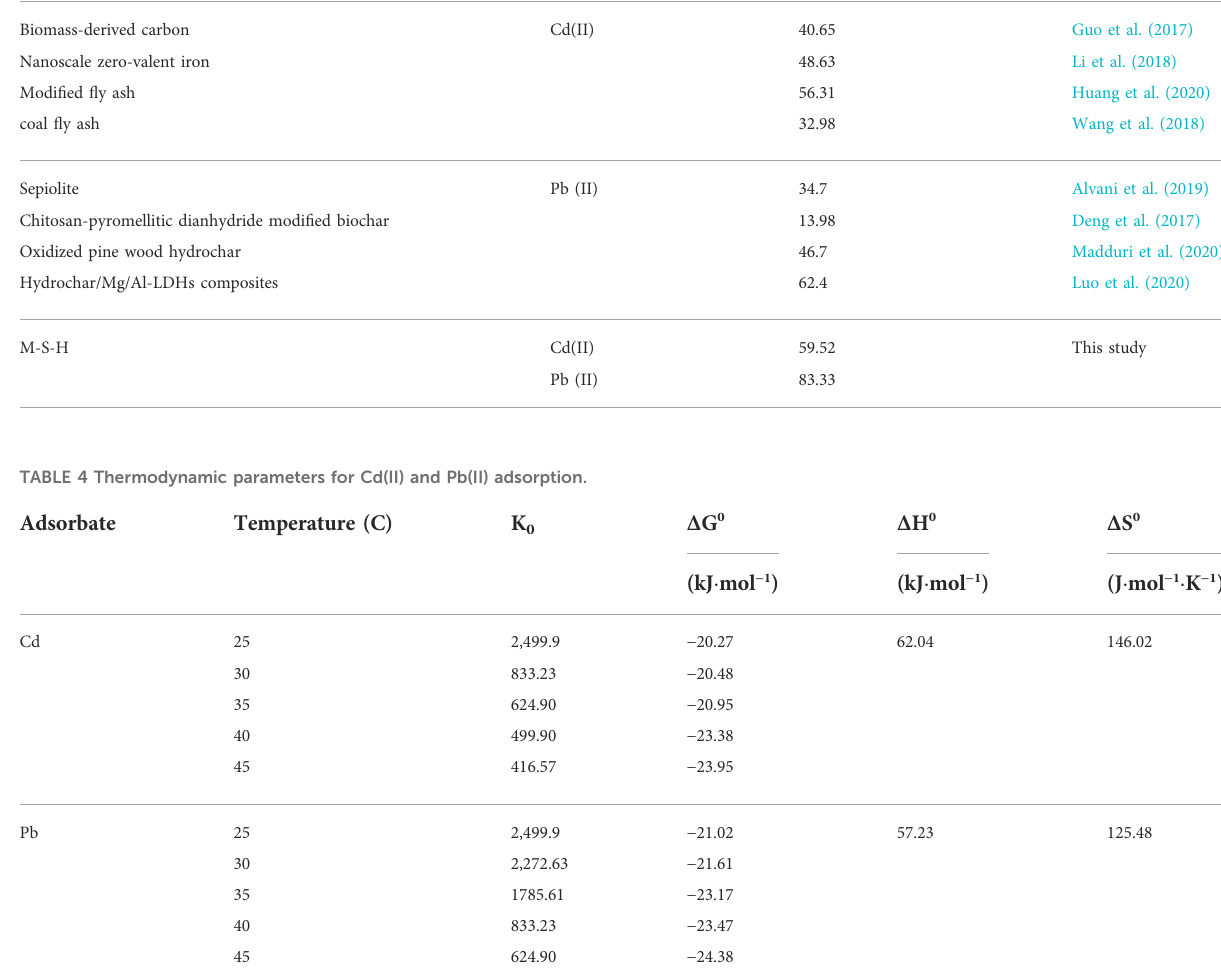
TABLE 3 Comparison of Cd(II) and Pb(II) adsorption onto M-S-H synthesized by coal-gangue with other adsorbents.